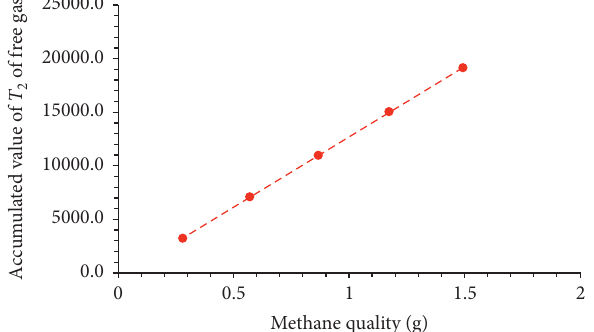
Figure 8: Calibration curve of gas quality and signal